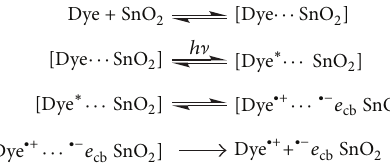
Scheme 2: Schematic diagram describing the conduction and valence band potentials of SnO 2 and the electron-donating energy levels of dyes.